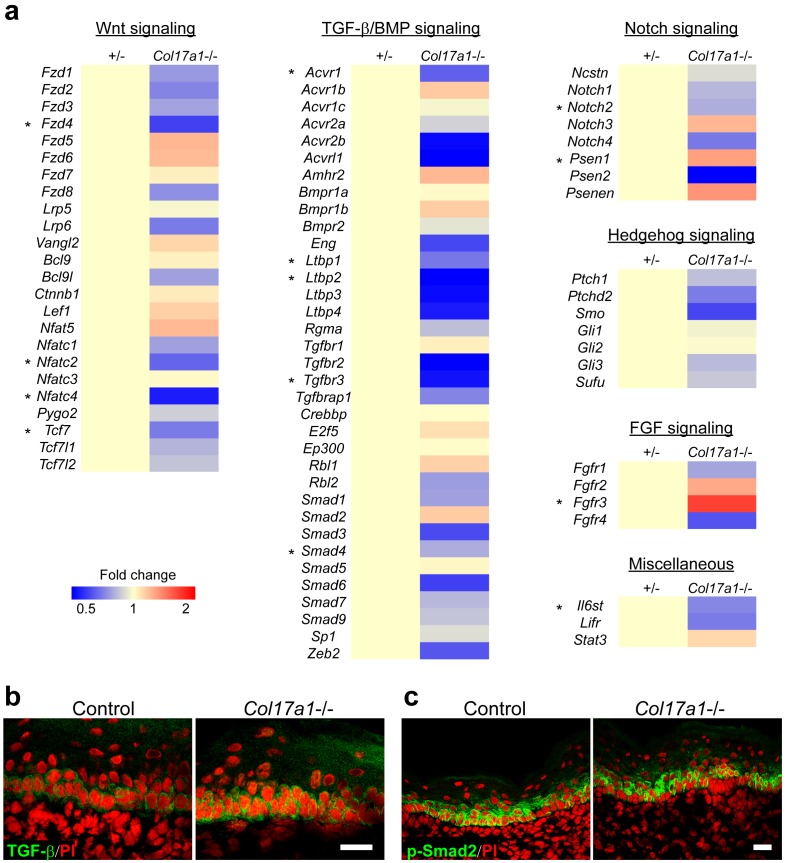
mRNA profiles of signaling molecules and TGF-β staining.(a) qRT-PCR screening of genes involved in the Wnt, TGF-β/BMP, Notch, Hedgehog, and FGF signaling pathways. mRNA samples from IFE skin of Col17a1−/− and littermate controls at P1 were analyzed (n = 5). *0.01<p<0.05, Student’s t-tests. (b) TGF-β-stained IFE of Col17a1−/− and littermate controls at P1 (representative images from three mice). (c) p-Smad2 staining of IFE from Col17a1−/− and littermate controls at P1 (representative images from three mice). Scale bar: 20 μm.